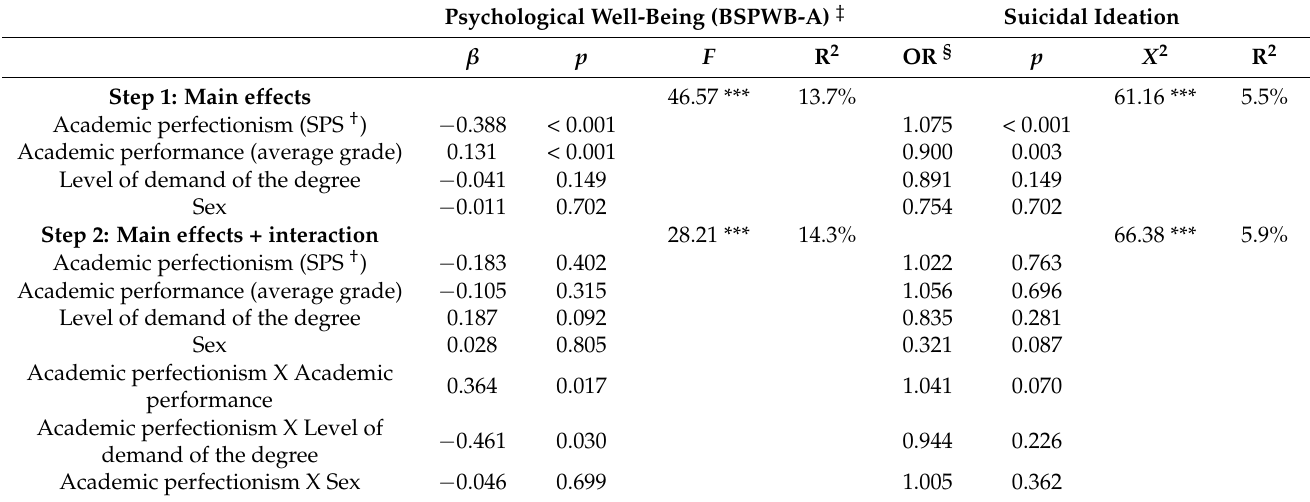
Table 2. Predictors of psychological well-being (linear regression) and suicidal ideation (logistic re-